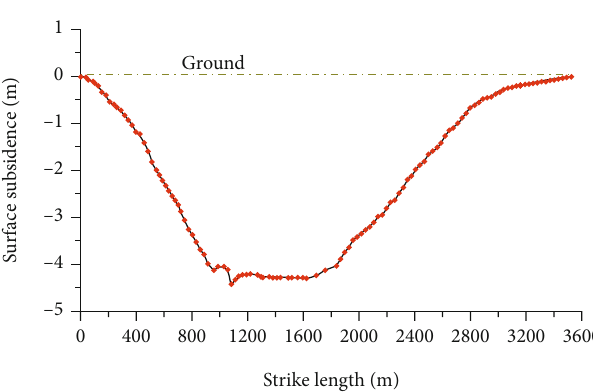
Figure 1: Surface subsidence curves along strike